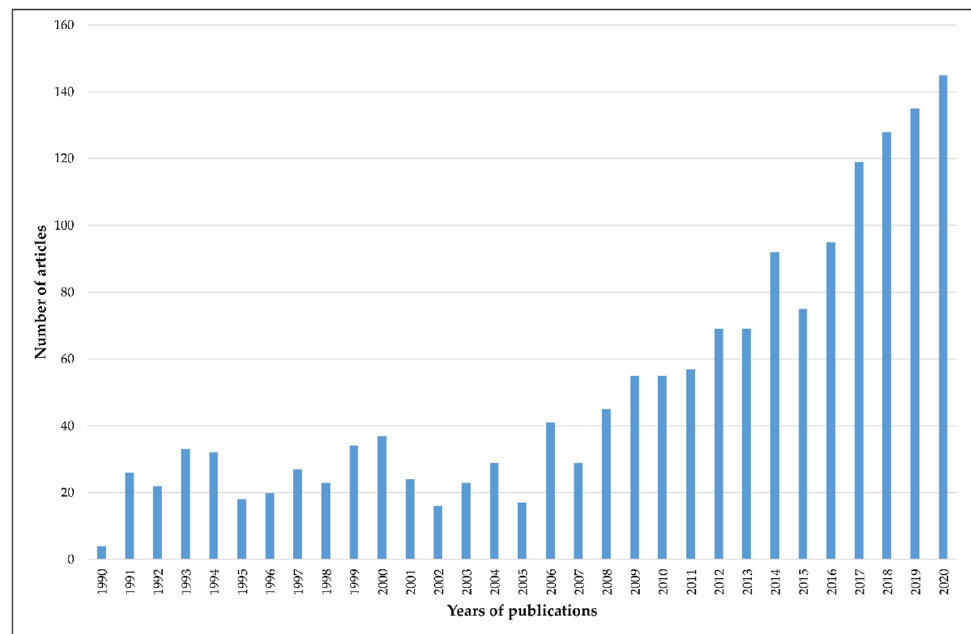
Figure 2. The number of publications in the last three decades regarding plant-derived mucilage based on Web of Science Core Collection.